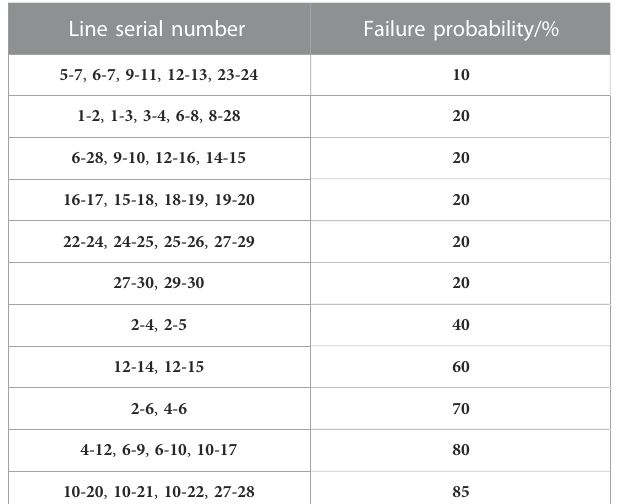
TABLE 3 Line fault probability.